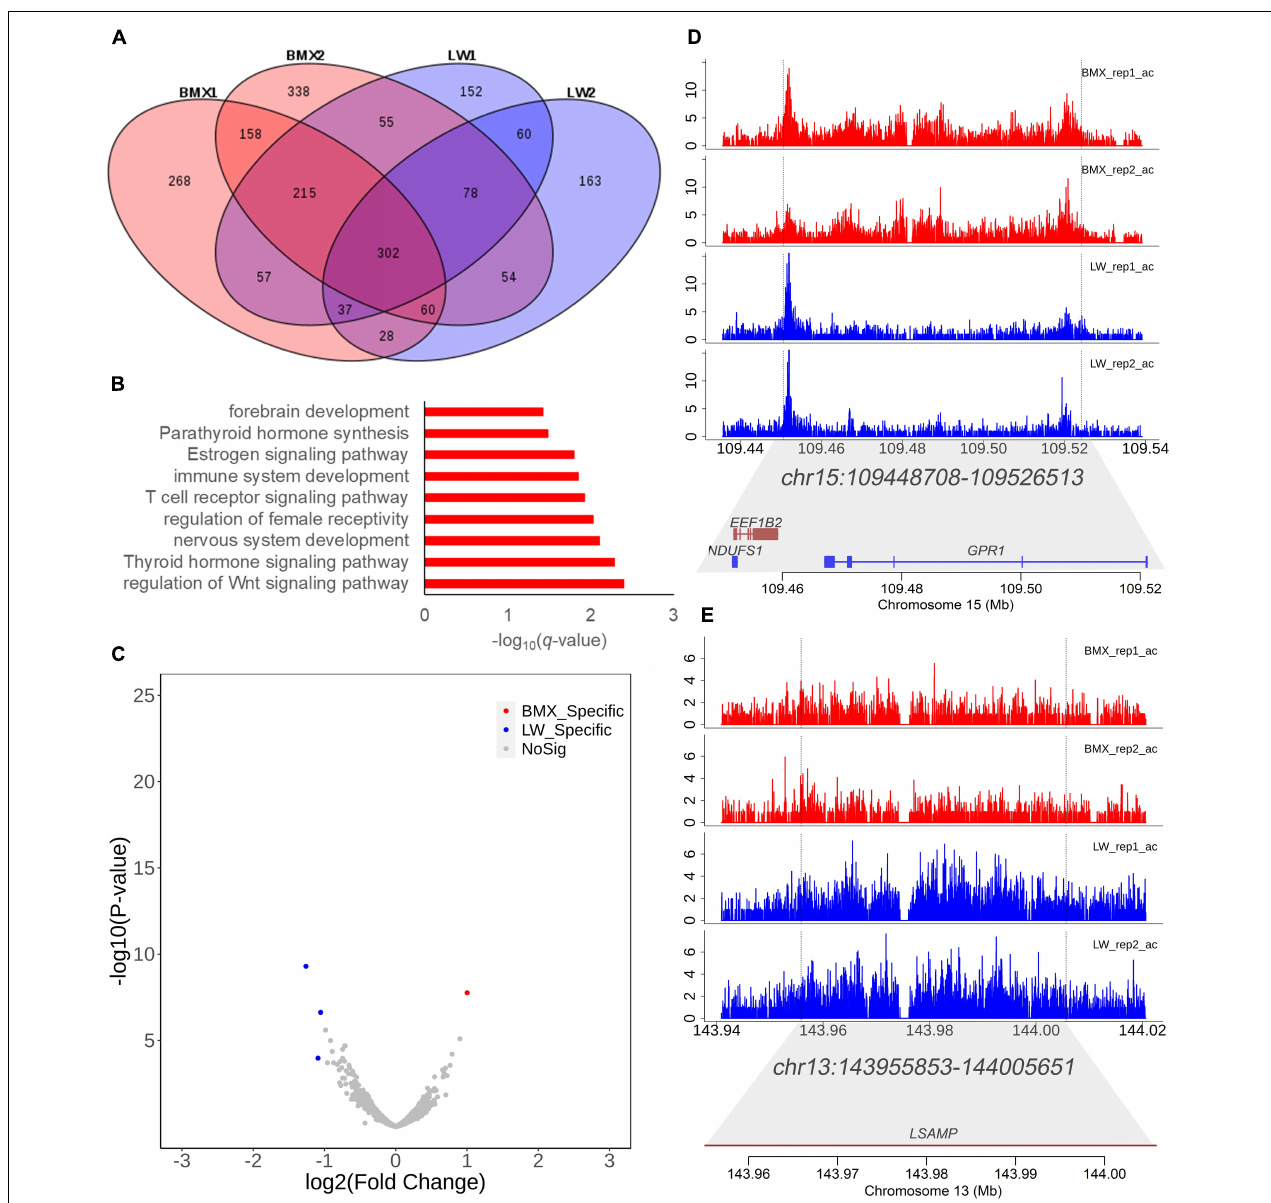
FIGURE 4 | Analysis of super enhancers. (A) The distribution of super enhancers in the four individuals. (B) Enriched Gene Ontology terms for genes covered by the 302 super enhancers shared cross all samples. (C) Volcano plot showing the differential activity analysis of super enhancer between two breeds. (D,E) The tracks of H3K27ac activity and gene in the two representative super enhancers that show differential activity between two breeds for reference (Chr15:109448708–109526513 and